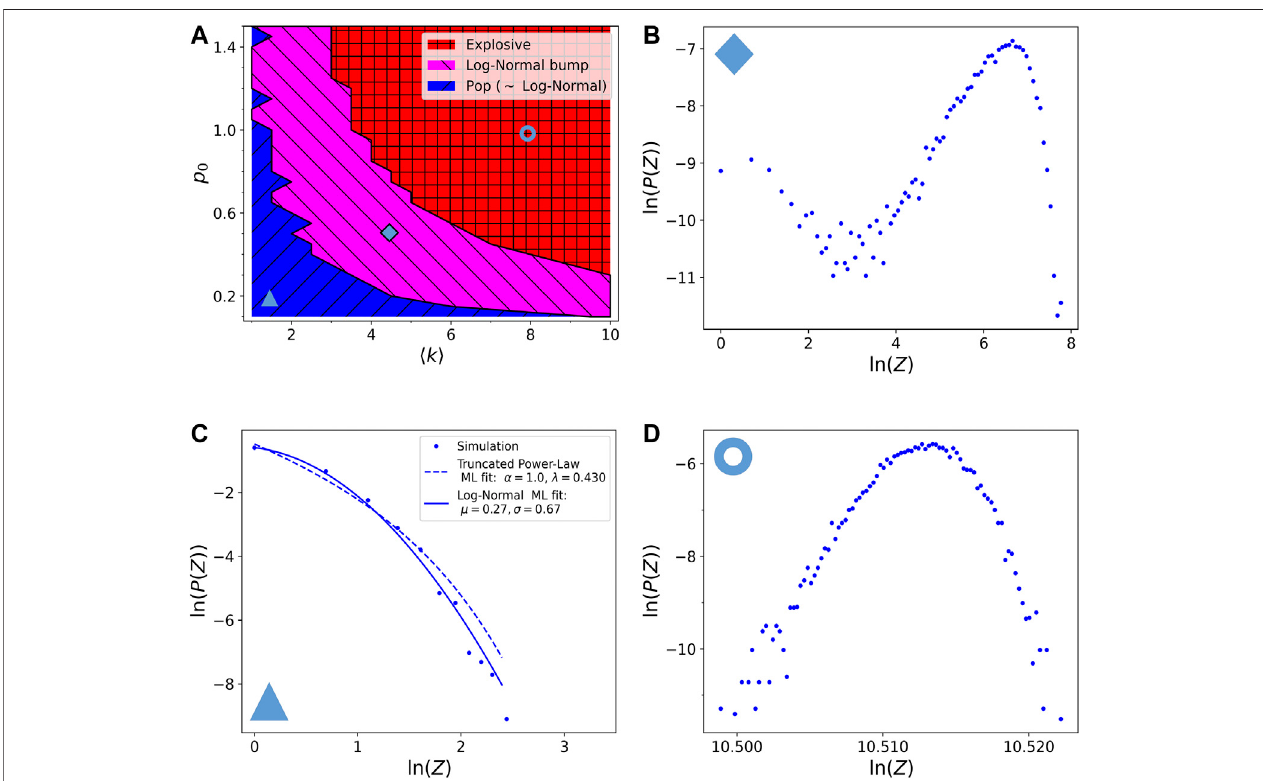
FIGURE 4 | Phase diagram of the resulting avalanche size distributions with respect to the model parameters 〈 k 〉 and p 0 , the constant pre-factor of the breaking probability (see Eq. 8 ). The time constant is τ (cid:1) 4 and the rheological exponent is α (cid:1) 0 . 3. Symbols indicate the points taken to show some distribution examples in the remaining panels. The pop (blue) and explosive (red) regimes are the same as in Figure 3 , while the mixed regime changes, becoming composed of a broader bump, approximately log-normally distributed (in magenta), together with some small avalanches reminiscent of the pop regime. This regime is called here log-normal bump (magenta); (B) Example distribution ofthe log-normal bump regime withcoordinates at thediamond point ( 4 . 5 , 0 . 55 ) ; (C) Example distributionofthe pop regime, withcoordinatedatthetrianglepoint ( 1 . 5 , 0 . 2 ) .Dotsshowthesimulationdistributionandthefull(resp.dashed)lineshowsthemaximumoflikelihood fi twithalog-normal (resp. truncated power-law) distribution; (D) Example distribution of the explosive regime, with coordinates at the doughnut point ( 8 , 1 )